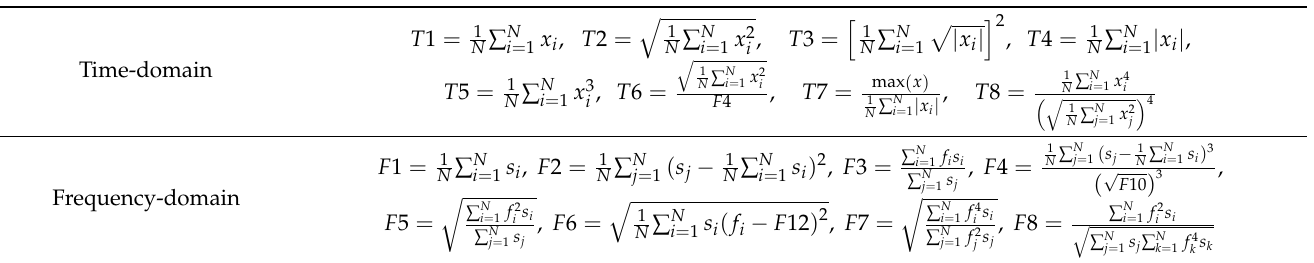
Table 2. Original features.